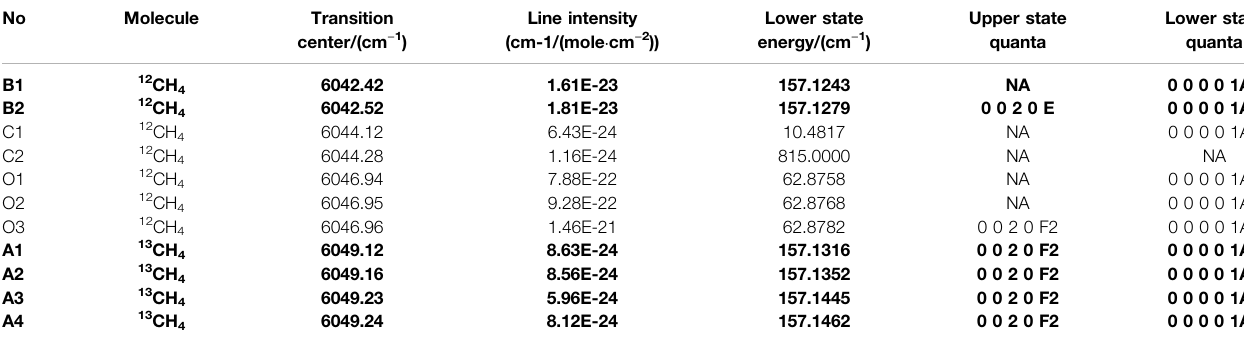
TABLE 1 | The spectral parameters of 13 CH 4 and 12 CH 4 candidate